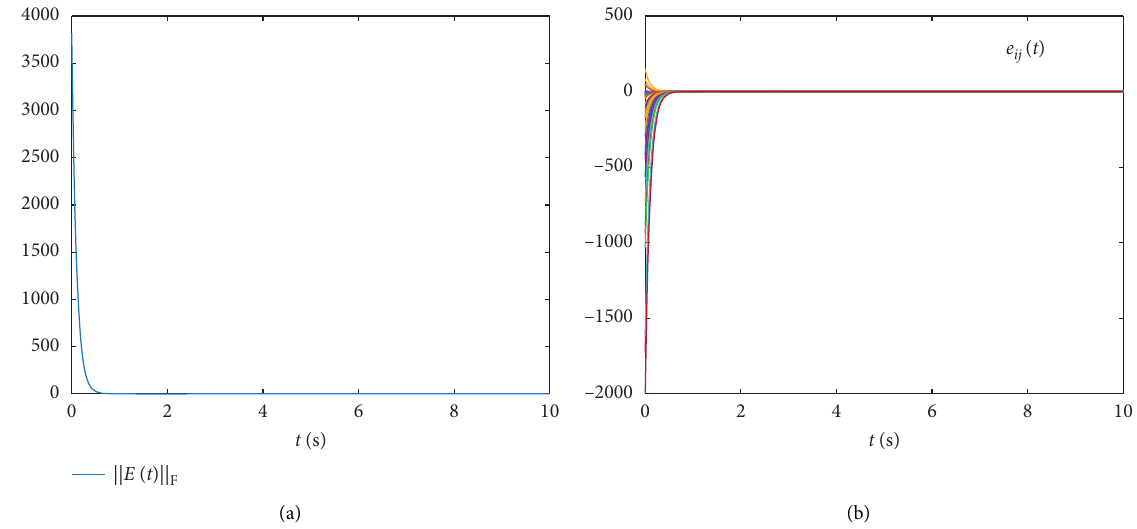
Figure 4: Experiment results synthesized by CTLUD model with λ � 10 and s ( 0 ) � 1 2 ·· · 21 1 2 ·· · 28 􏼂 􏼃 T for solving 7-dimensional time-varying LU decomposition problem in Example 3. (a) Frobenius-norm trajectory of error matrix E ( t ) . (b) Trajectories of e ( t ) , and e ( t ) . ... , e 67 77